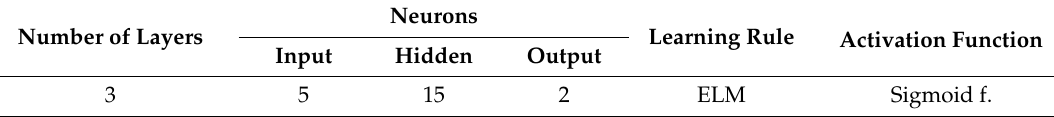
Table 2. The parameters of the user-defined function. Number of Layers